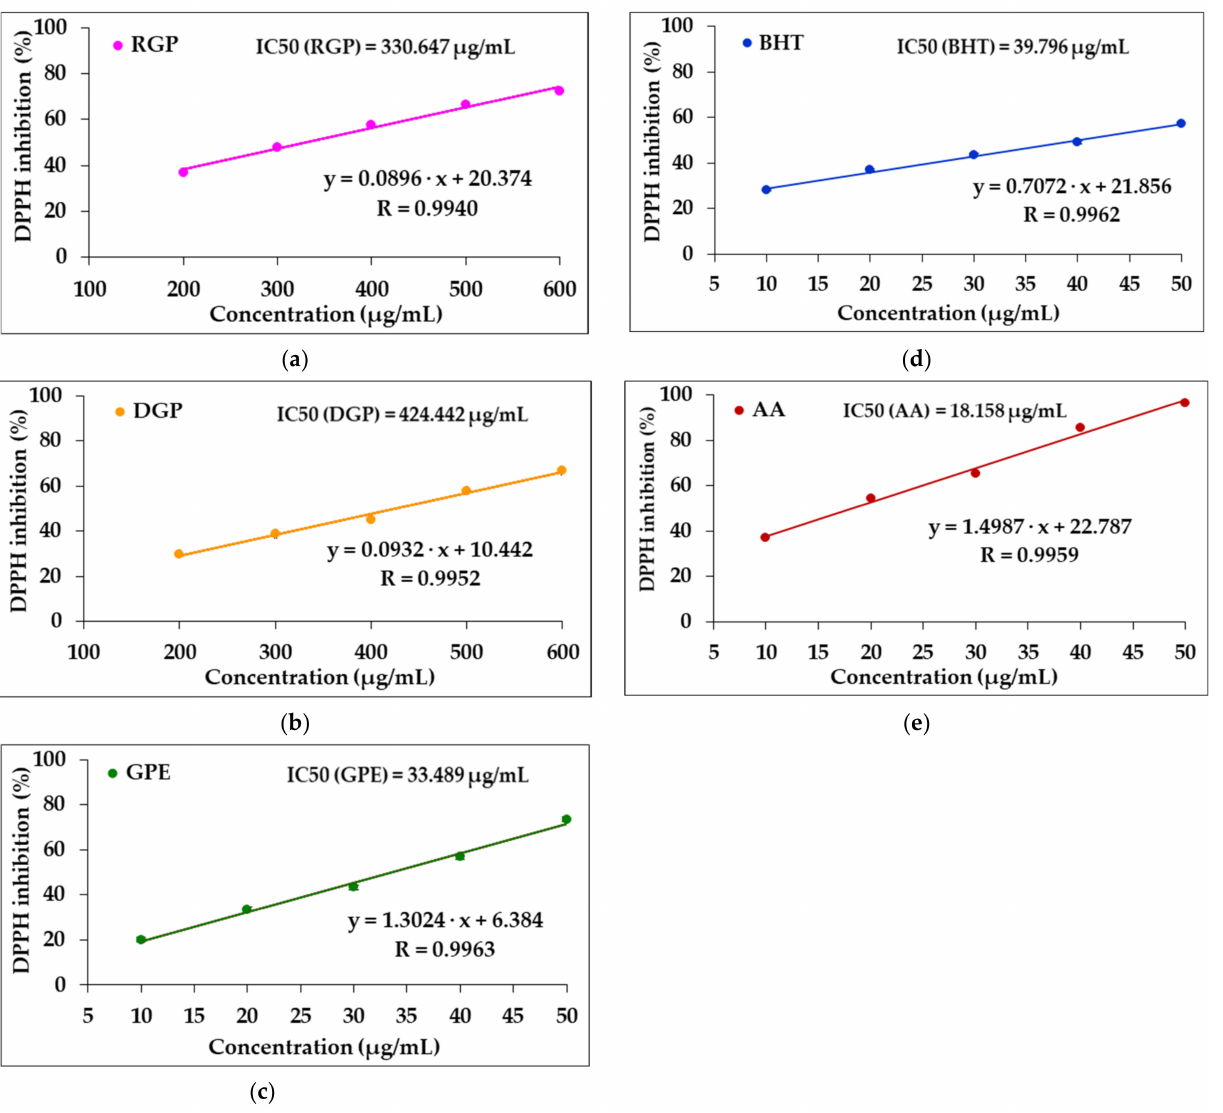
Figure 1. Percentage of DPPH inhibition (%) versus the sample concentration: ( a ) raw grape pomace (RGP); ( b ) dried grape pomace (DGP); ( c ) grape pomace extract (GPE); ( d ) butylated hydroxytoluene (BHT); ( e ) ascorbic acid